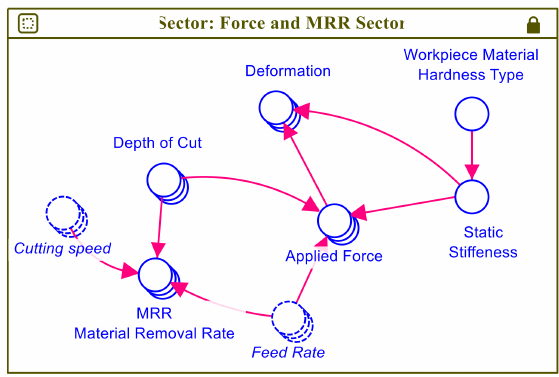
Figure 13. Structure of Force and